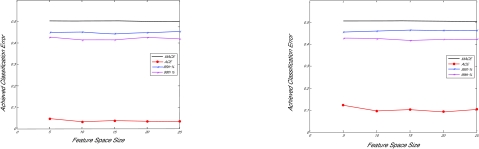
PACE analysis using a SVM-based classifier using the AUC scoring criterion, with a 0.6 MAC threshold. Left Panel: performance without peak selection. Right panel: performance with peak selection.